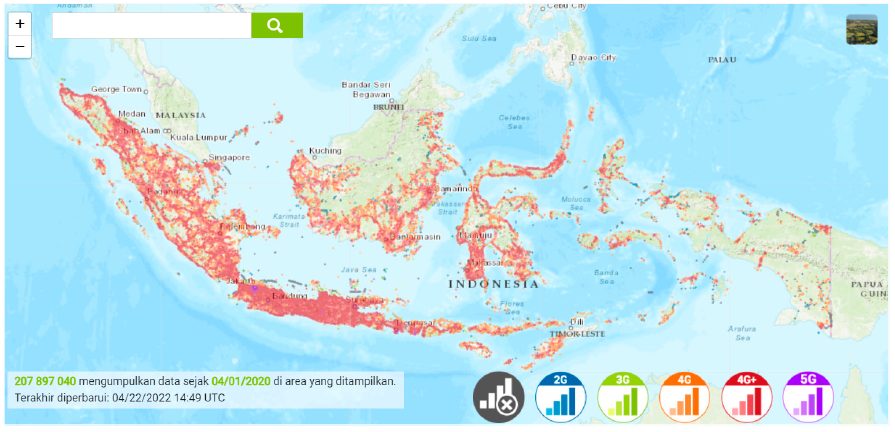
Figure 2. Map of Telkomsel Telecommunication Network Distribution in Indonesia. Source: